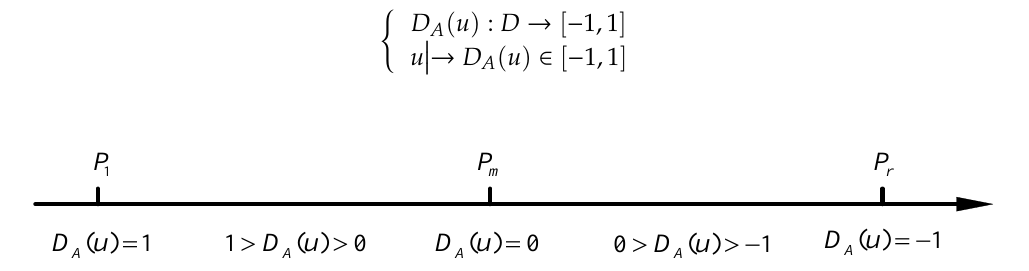
Figure 2. Diagram representing the relative difference function.